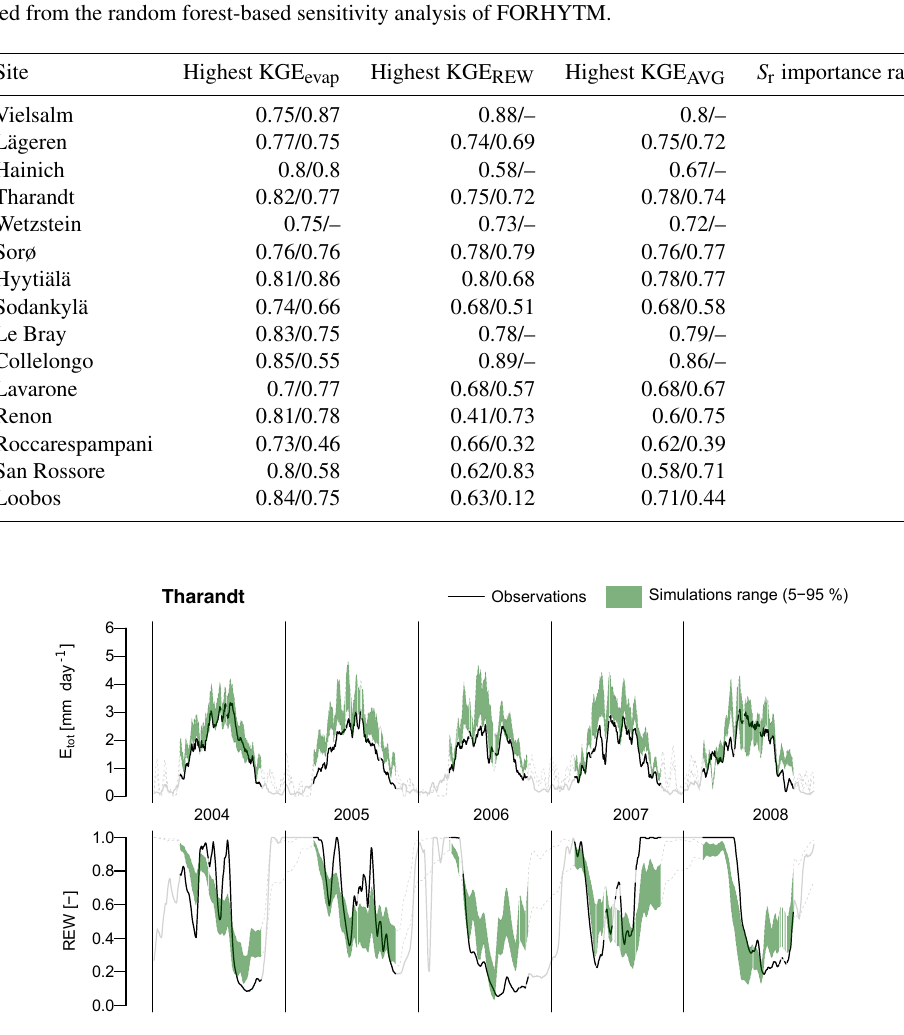
Table B2. Highest KGE scores obtained at each site for calibration (first number) and validation (second number). For the validation pe- riod, only scores obtained with calibrated S r are counted. The last column indicates the importance rank of S r out of the seven calibration parameters, obtained from the random forest-based sensitivity analysis of FORHYTM.